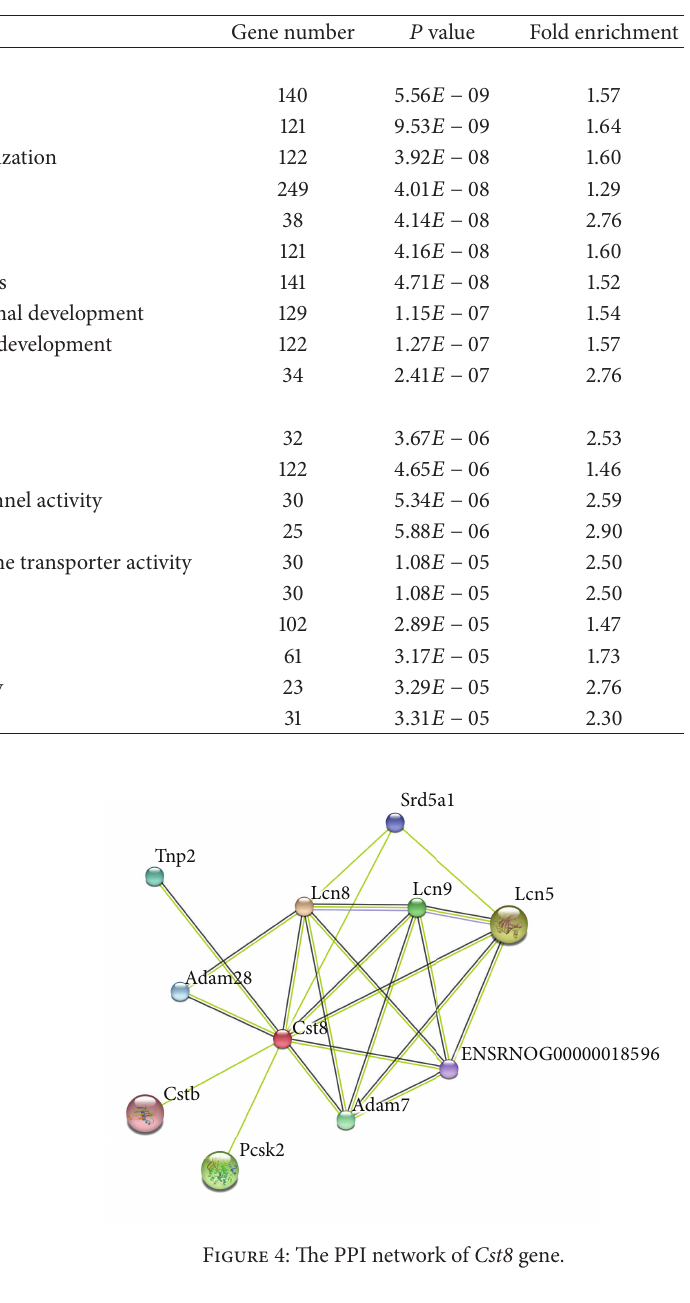
Table 3: GO enrichment analysis of DEGs in earlier stage (upper) and later stage (lower).